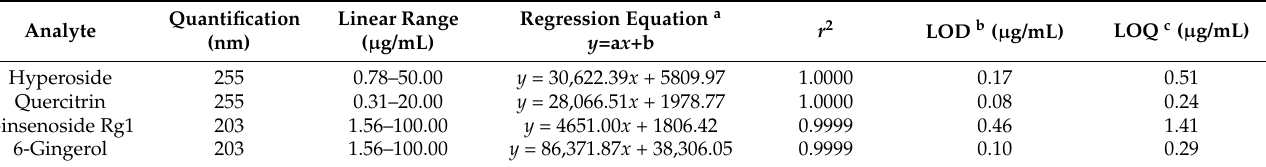
Table 1. Linear range, regression equation, coefficient of determination ( r 2 ), limit of detection (LOD), and limit of quantifica- tion (LOQ) of the four marker analytes for the quantification using HPLC ( n = 3). Quantification Analyte (nm) Hyperoside